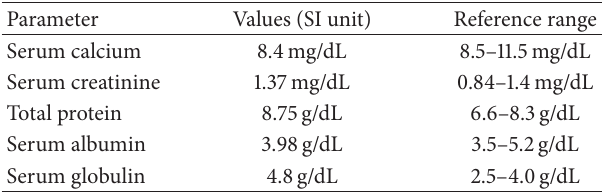
Table 2: Biochemical investigations.